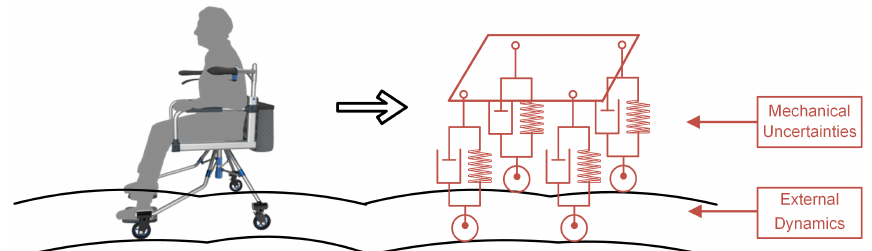
Figure 8. Uncertain physical interaction in the elderly rollator